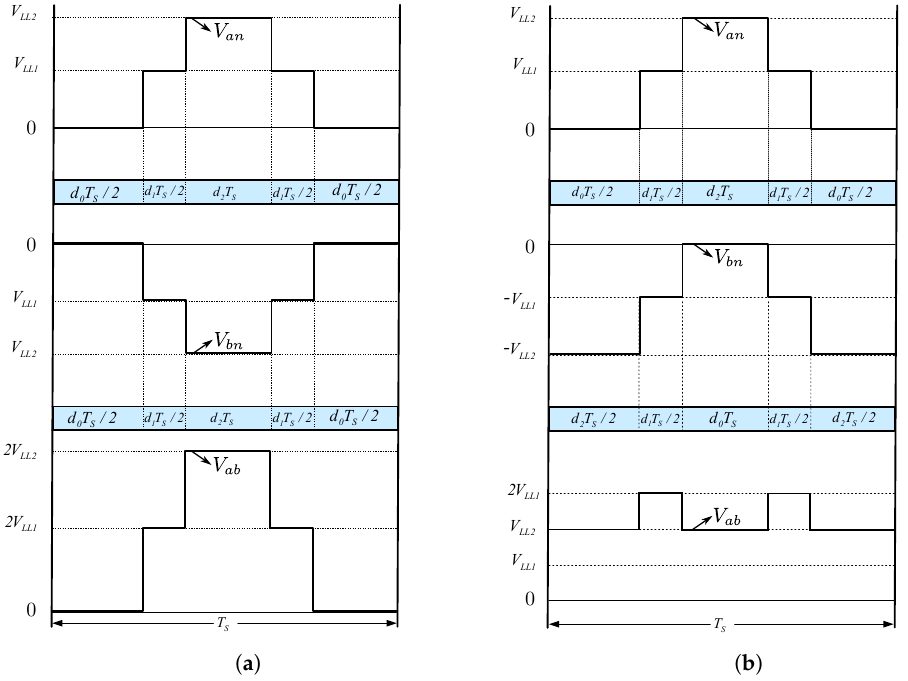
Figure 11. Output signal from switching pattern. ( a ) sequence I. ( b )sequence II.